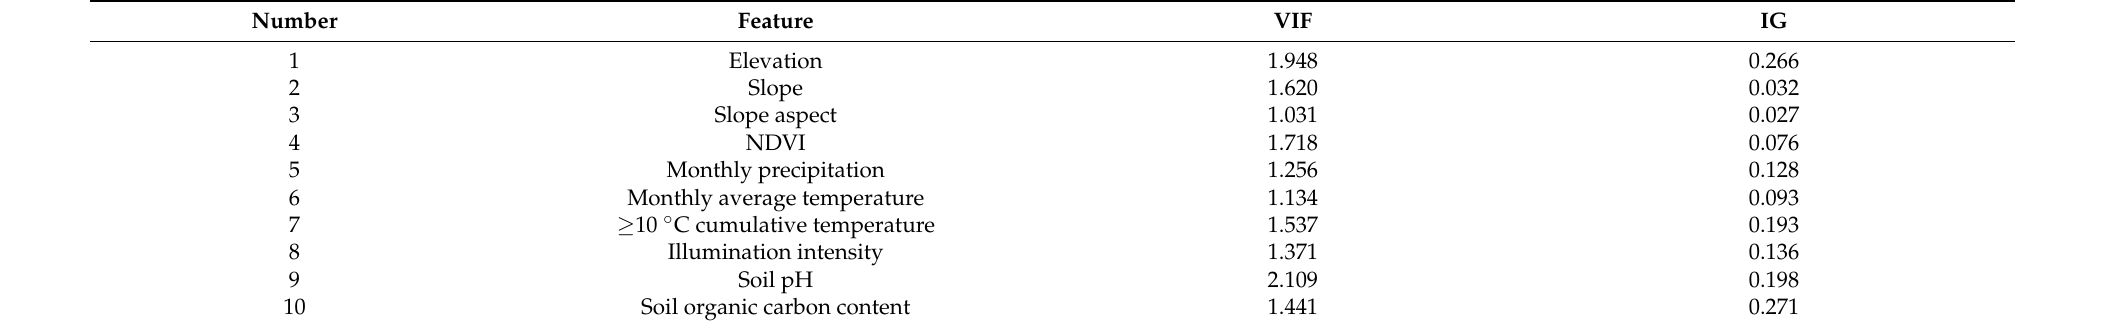
Table 5. VIF and IG for the features of ecological suitability.